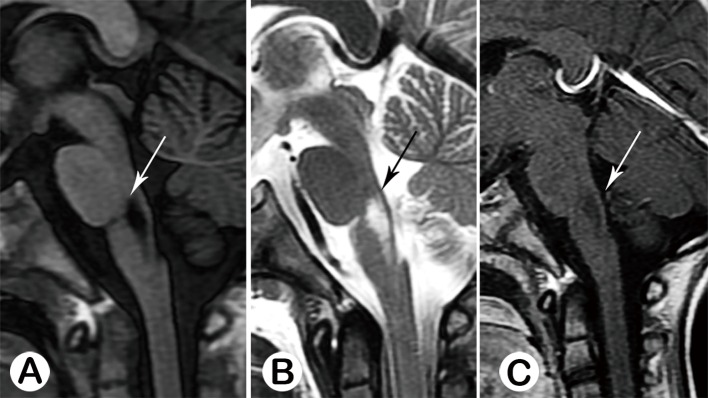
Convalescence Stage, Male, 4 years old, on the 28th day of the disease.MR images showed there is a longitudinalmalacia cavity at the posterior junction region of the pons and medulla, with prolonged T1 (A, white arrow) and prolonged T1 (B, black arrow) signal, without enhancement (C, white arrow). This subject had had impaired function of breath and recurrent pneumonia after discharge.